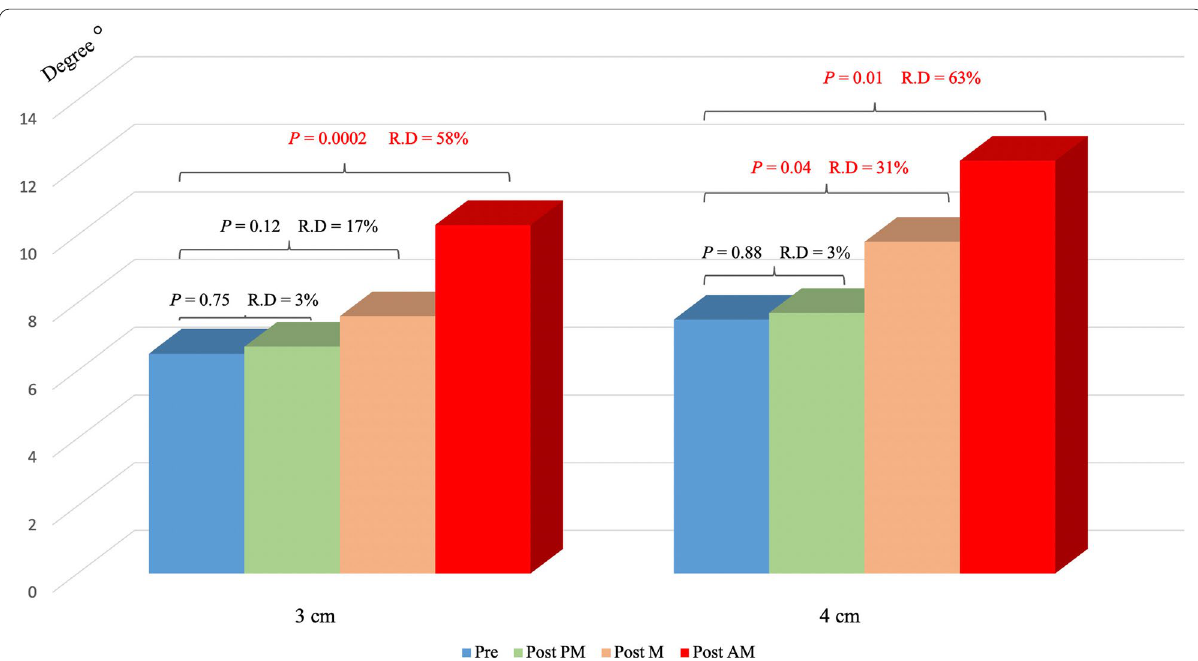
Fig. 6 Comparisons of preoperative and postoperative PTS, in the 3 and 4 cm groups. The red text indicates significant changes. R. D, relative difference; AM, anteromedial; M, medial; PM, posteromedial